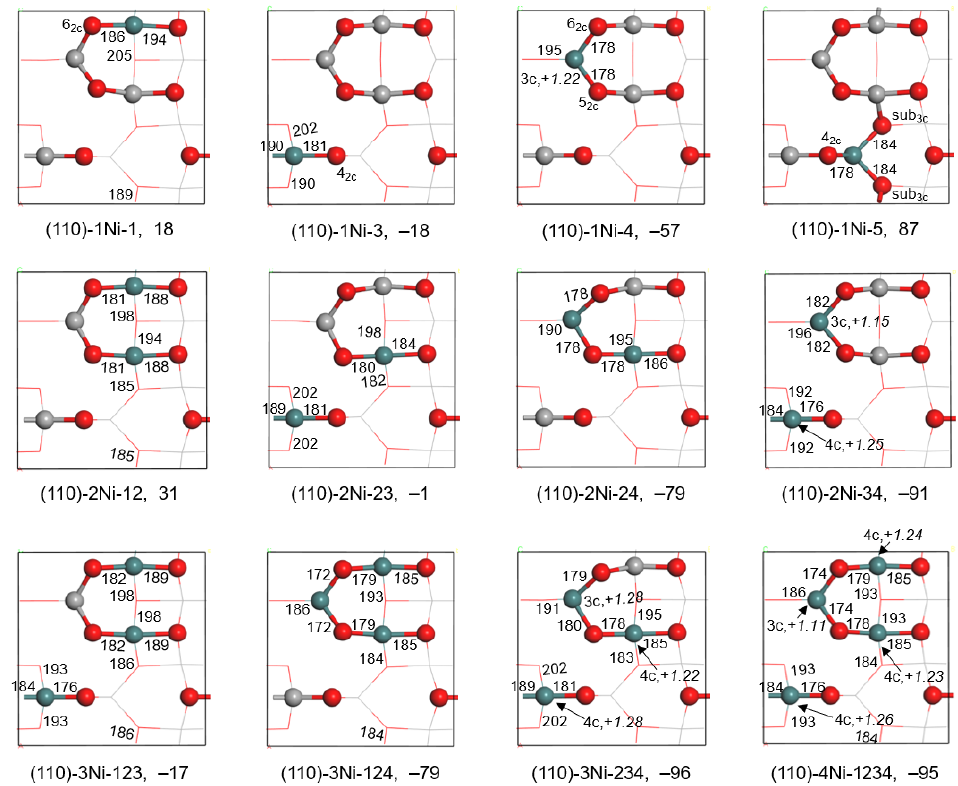
Figure 2. Ni 3+ substituted for 1~4 Al 3+ of γ -Al 2 O 3 (110) surface. The red, gray and olive-green balls represent the surface O, Al and Ni atoms, respectively. The coordination numbers and Bader charges of Ni atoms are next to the olive-green balls. The substitution energies (kJ/mol), Bader charges ( e ) and bond distances (pm) have been shown in the figure.